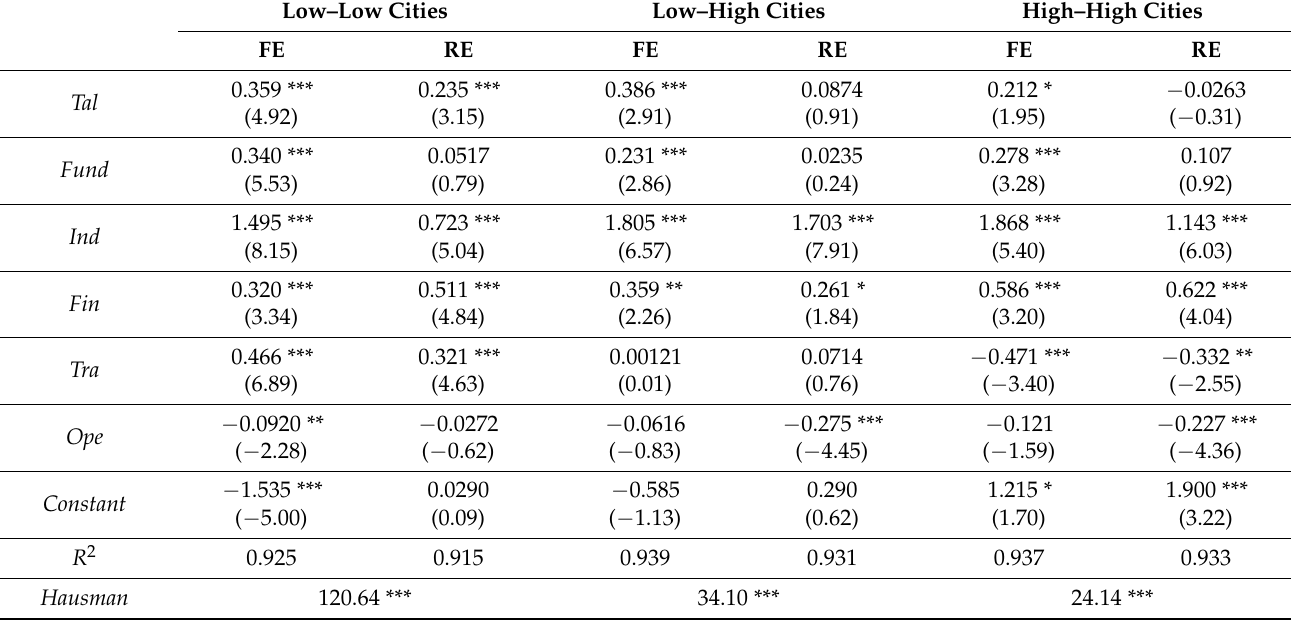
Table 2. Regression results for driving factors for innovation development in different types of cities. Low–Low